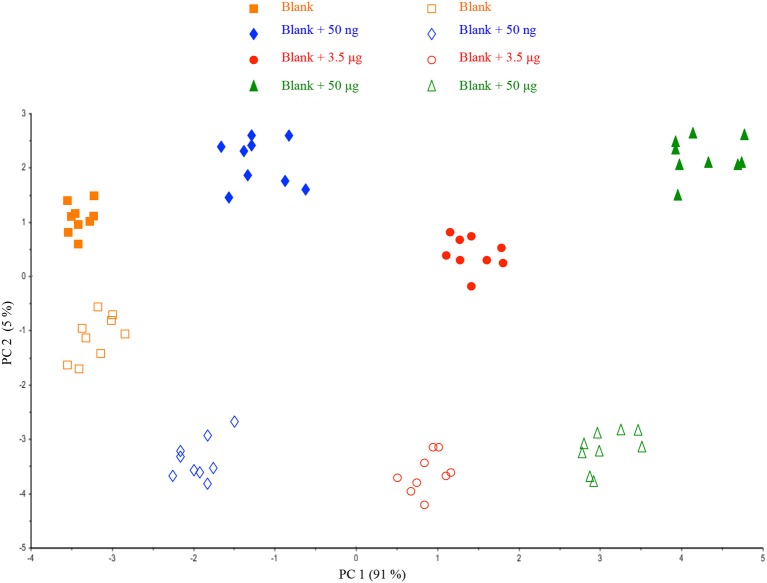
Scores plot of the Principal Component Analysis performed on the datasets from the two different ways of HU deposition on a filter.